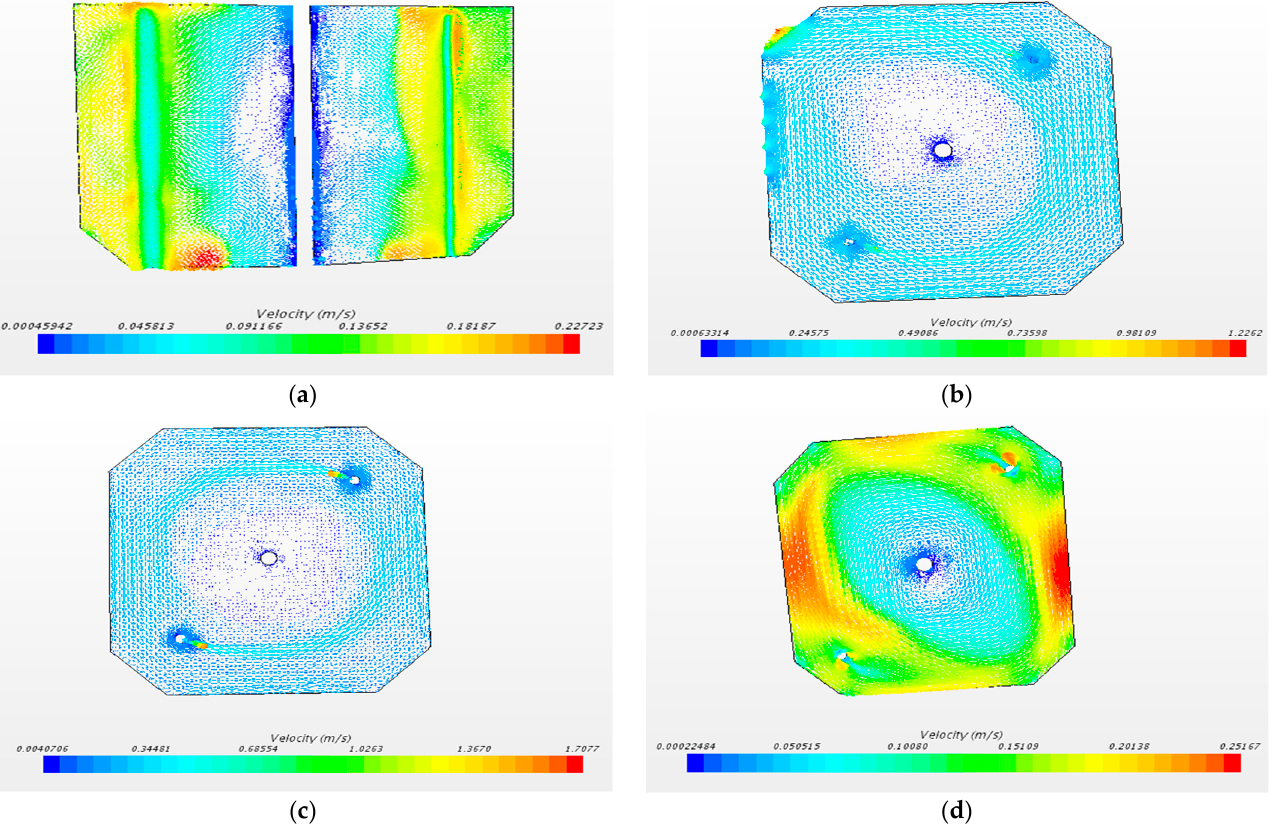
Figure 20. ( a ) middle longitudinal section, ( b ) H = 16.5 m cross section, ( c ) H = 8.5 m cross section, ( d ) H = 1.5 m cross section.